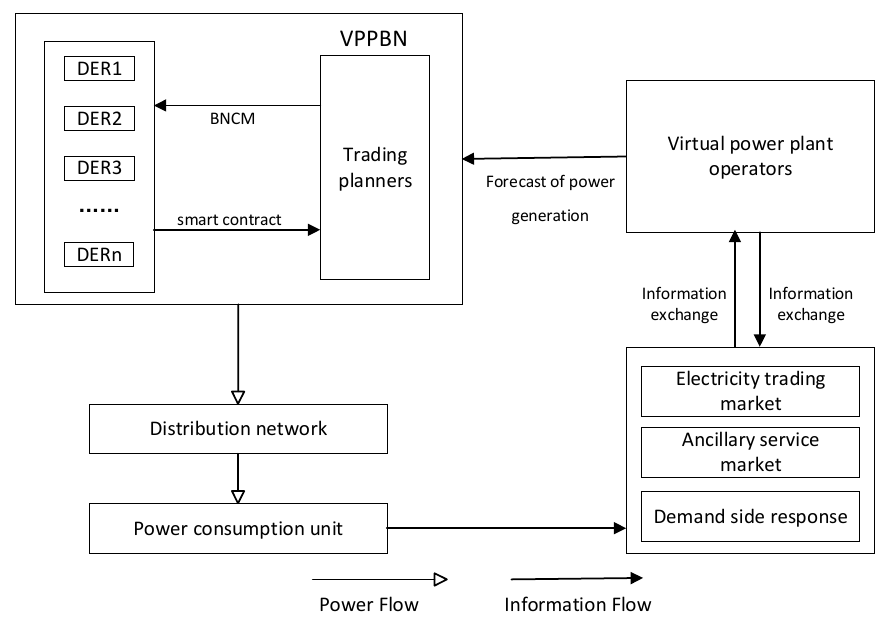
Figure 2. Working process of VPPTM based on blockchain.